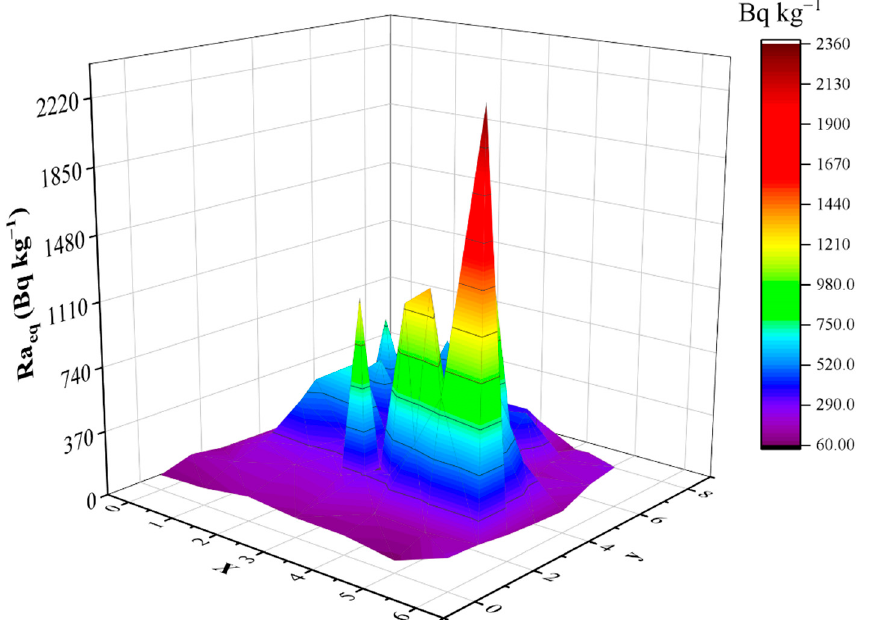
Figure 6. The radium equivalent content (Ra eq ) of the investigated muscovite granites in the studied area.